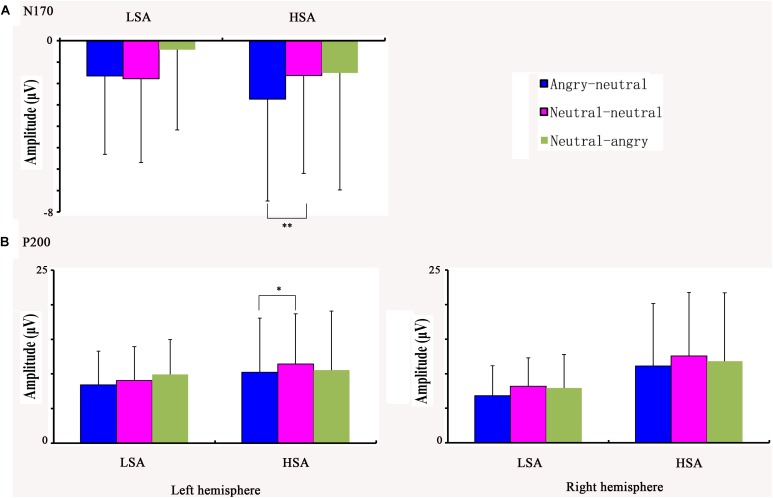
The average N170 peaks in each facial emotional change condition for HSA and LSA participants (A). The average P200 peaks in each facial emotional change condition for HSA and LSA participants at the left and right hemisphere electrodes (B) (∗p < 0.05, ∗∗p < 0.01).